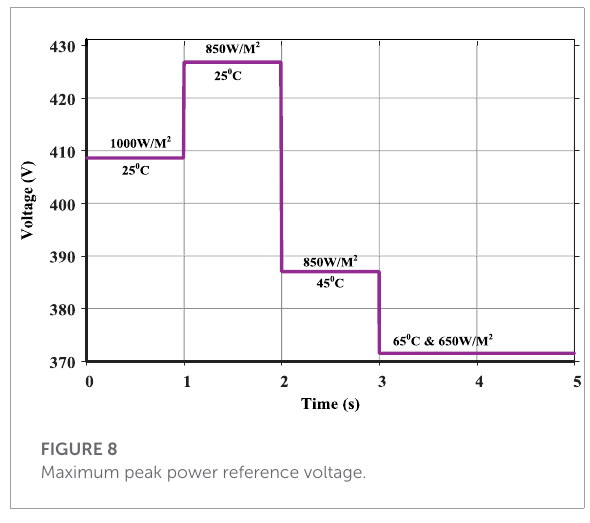
FIGURE 8 Maximum peak power reference voltage.